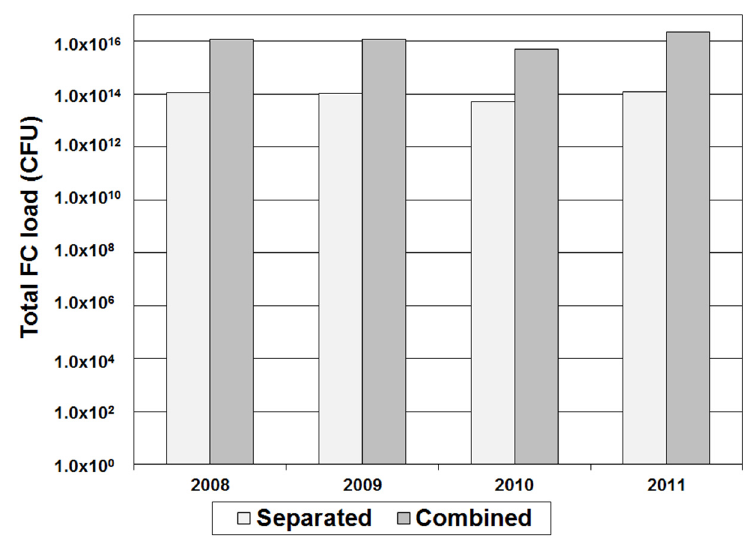
Figure 7. Estimated FC loads from the separate stormwater and combined sewer systems, for the May to August